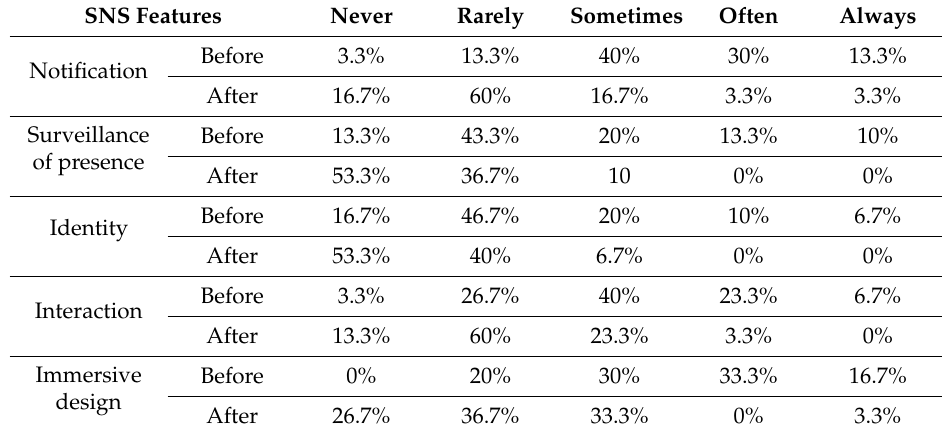
Table 9. Experiencing procrastination due to SNS triggers before and after using D-Crastinate